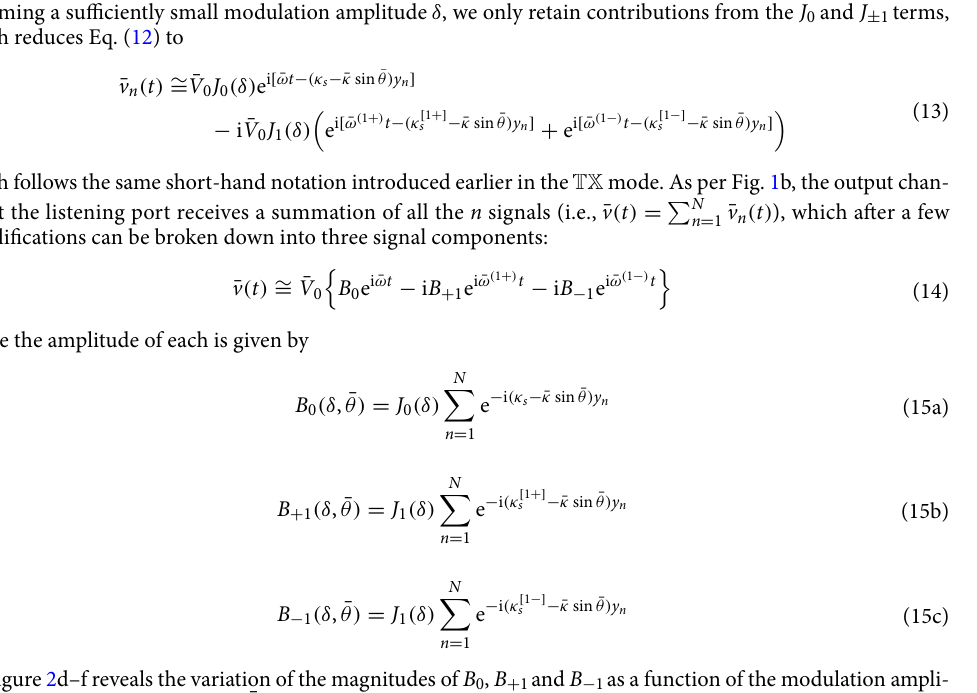
Figure 3. ( a ) Variation of the design parameter c κ s /ω with respect to θ s . ( b , c ) The design parameters ω m /ω and c κ s /ω as functions of θ s , parameters ω m /ω and c κ s /ω as functions of θ s , 0 ω m =